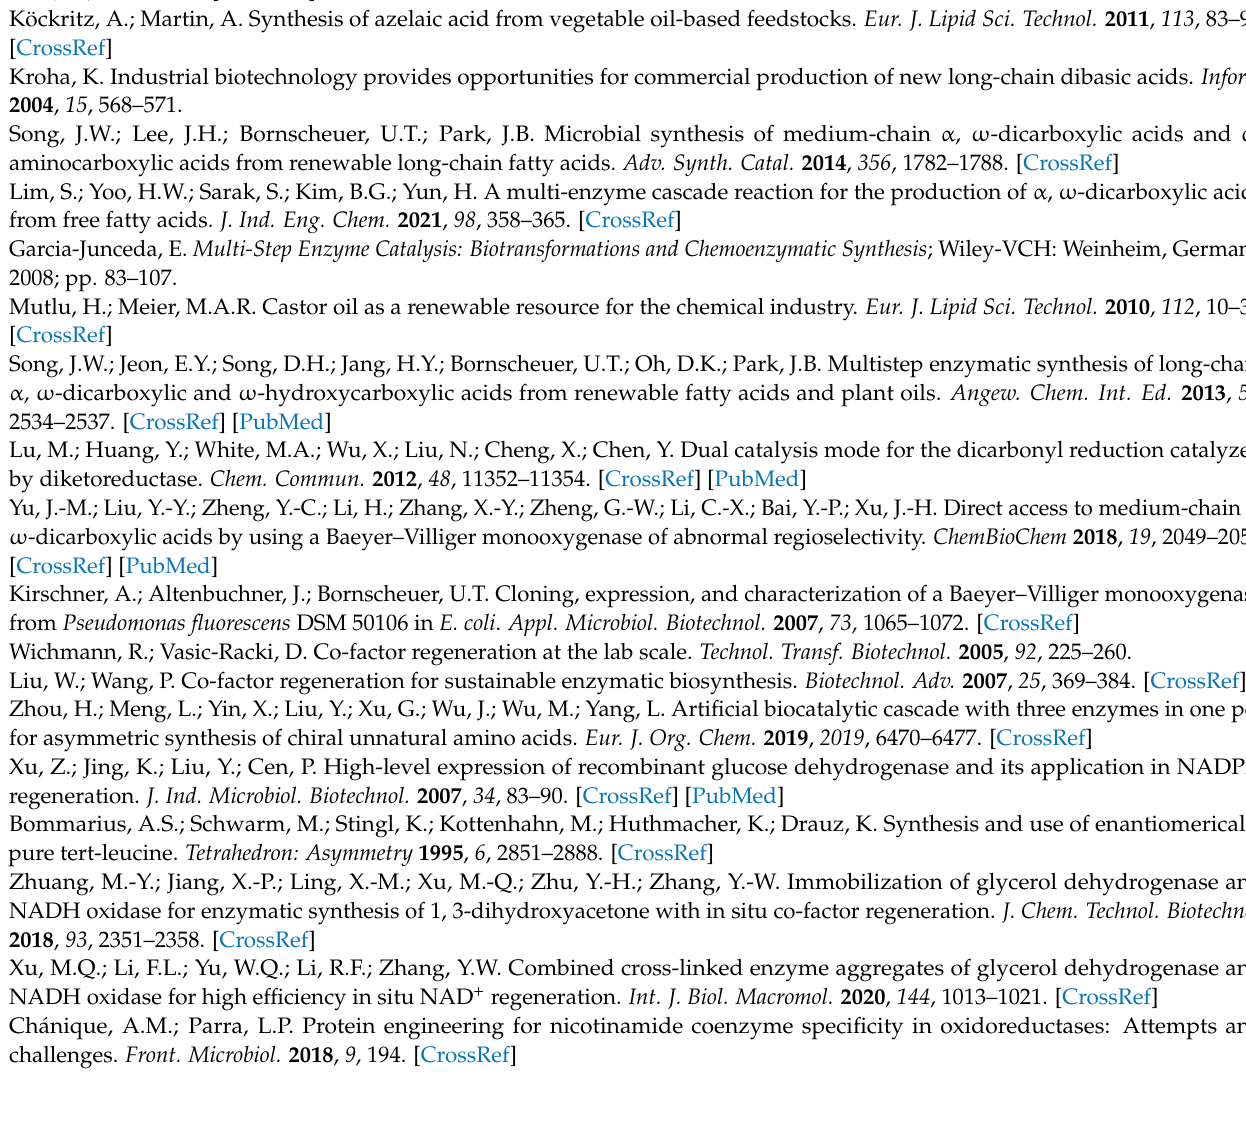
Figure S8: Comparison of simulation results of homology model from 4E12 and 6KQ9 with reasonable mutation candidates. Figure S9: Simulation results of reasonable mutation candidates with PDB 6KQ9 as